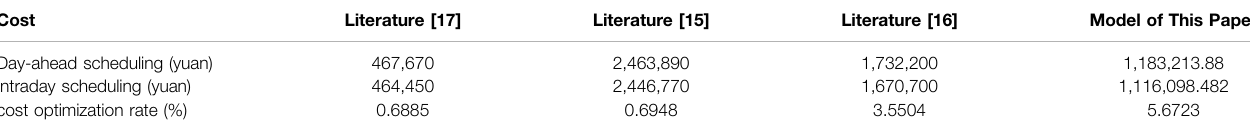
TABLE 3 | Comparison with the results of the operating cost of similar literature